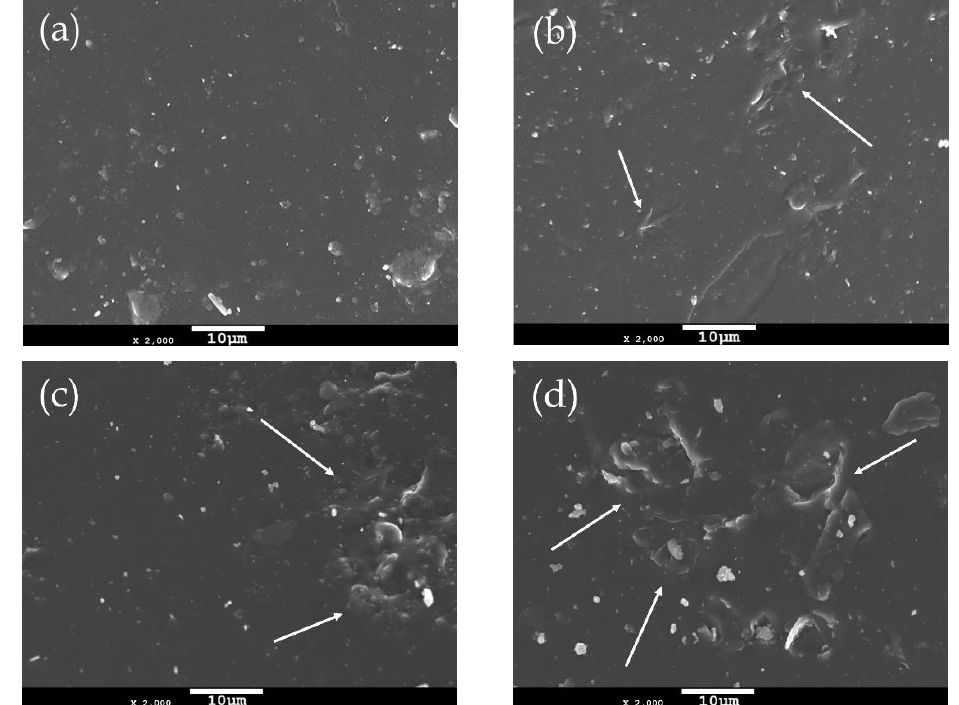
Figure 1. SEM images of the surfaces of ( a ) neat PEF and PEF/GNPs, nanocomposites containing ( b ) 0.5, ( c ) 1, and ( d ) 2.5 wt. % GNPs. ( b ) 0.5, ( c ) 1, and ( d ) 2.5 wt. %